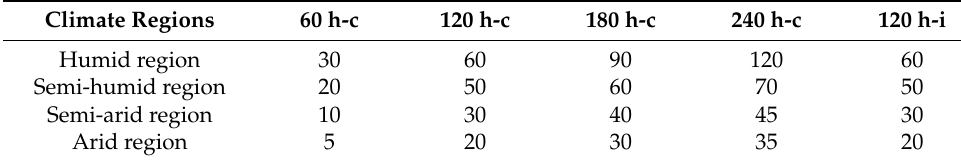
Table 4. Thresholds of different training lengths for each climate